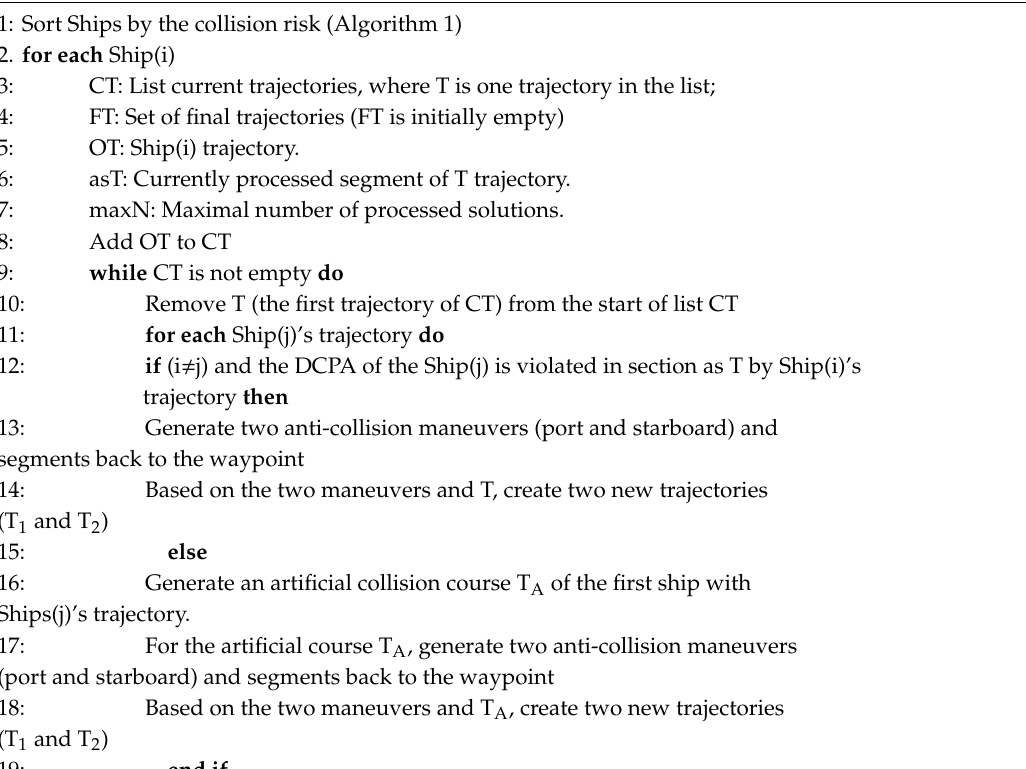
Algorithm 2: Multi-ship Beam Search